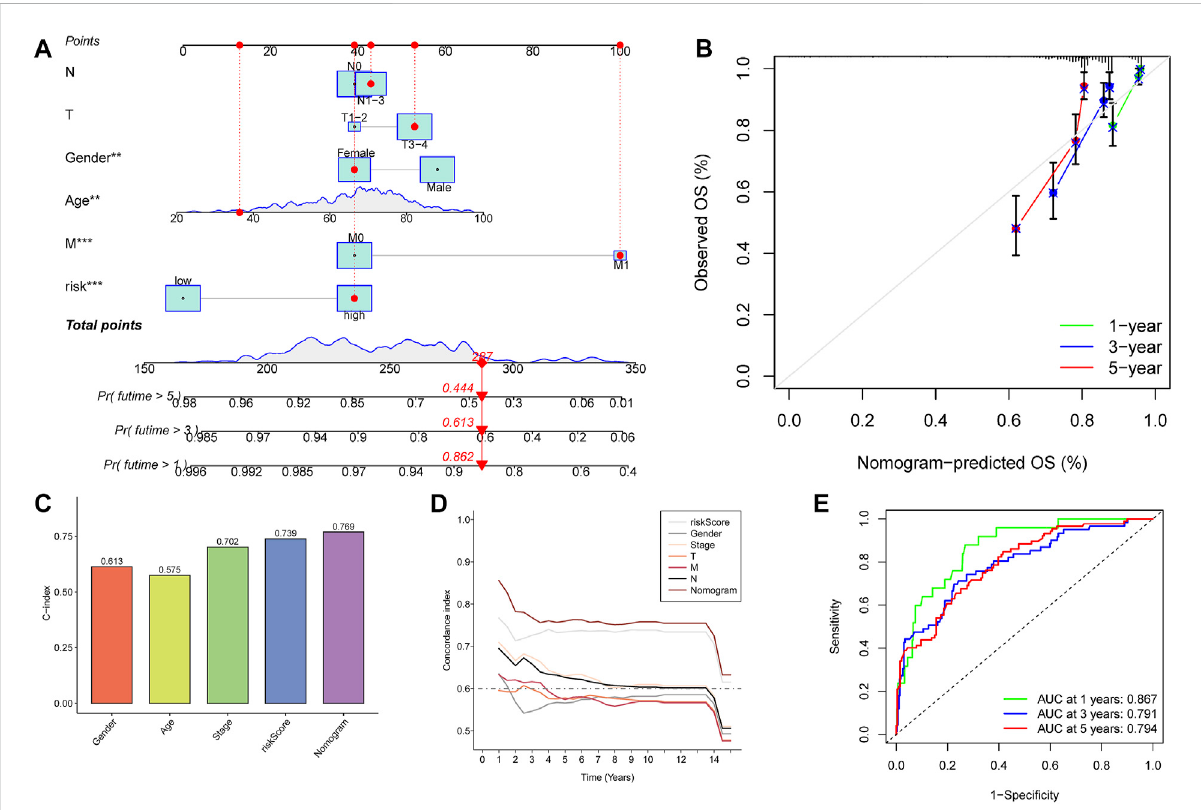
FIGURE 6 Construction and calibration of nomogram. (A) Nomogram integrating risk and clinical characteristics. (B) Calibration of the nomogram at 1-y, 3-y, and 5-y survival in the TCGA cohort. (C,D) C-index estimates the probability that the predicted results are consistent with the actual observed results. (E) Time-dependent ROC curve of the constructed nomogram